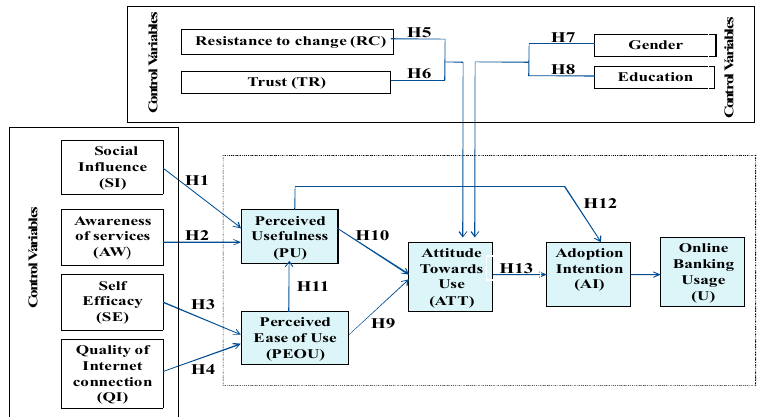
Fig. 2. Proposed research model—the extended